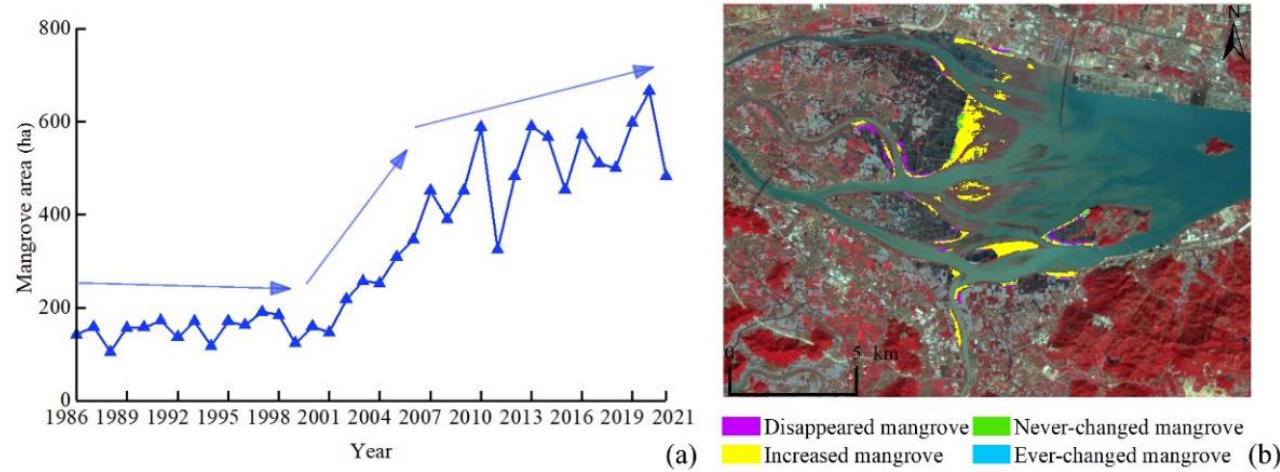
Figure 14. ( a ) Mangrove area and ( b ) changes to mangroves in ZNNR during 1986 – 2021.